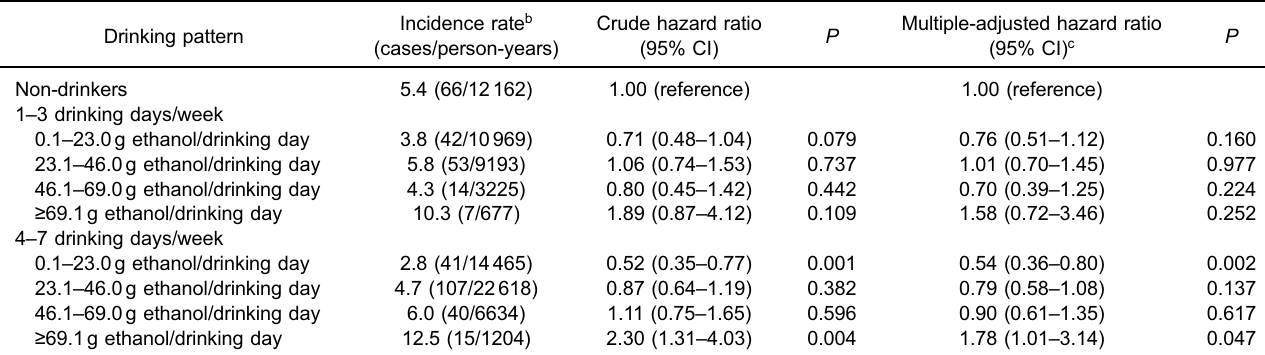
Table 4. Incidence rates and hazard ratios for consecutive proteinuria a according to the drinking pattern Incidence rate Drinking pattern